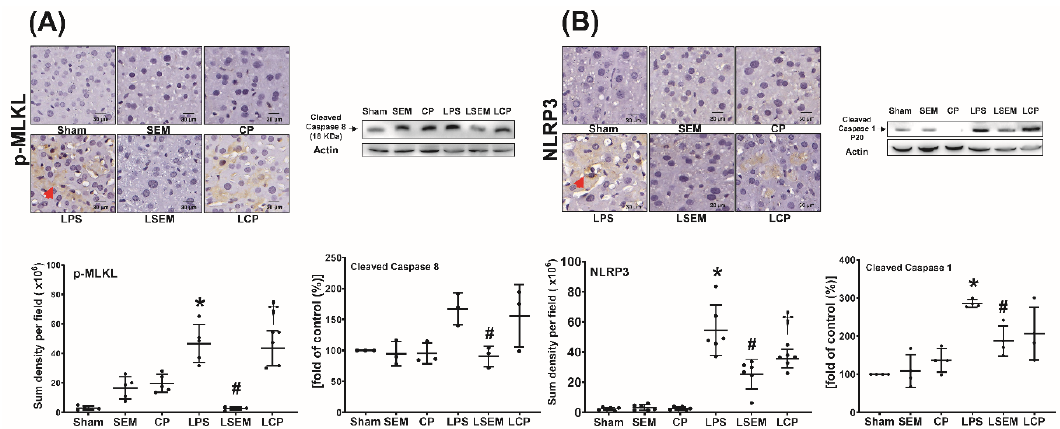
Figure 5. SEM18 peptide mitigates endotoxin-induced ( A ) necroptosis and ( B ) pyroptosis in the liver, measuredat24hafterlipopolysaccharide(LPS)ornormalsaline(NS)administration. ( A )Representative as measured at 24 h after lipopolysaccharide (LPS) or normal saline (NS) administration. ( A ) microscopic images of phosphorylated mixed lineage kinase domain-like pseudokinase (p-MLKL, red Representative microscopic images of phosphorylated mixed lineage kinase domain-like arrow) in liver tissues (200 × ) measured using immunohistochemistry assay and the quantitative sum pseudokinase (p-MLKL, red arrow) in liver tissues (200×) measured using immunohistochemistry assay and the quantitative sum intensity of p-MLKL. Representative gel photography of cleaved intensity of p-MLKL. Representative gel photography of cleaved caspase 8 and actin (the internal caspase 8 and actin (the internal standard) in liver tissues and the cleaved caspase 8/actin band standard) in liver tissues and the cleaved caspase 8 / actin band density. ( B ) Representative density. ( B ) Representative microscopic images of nod-like receptor protein 3 (NLRP3, red arrow) in microscopic images of nod-like receptor protein 3 (NLRP3, red arrow) in liver tissues assayed liver tissues assayed using immunohistochemistry staining assay (200×) and the quantitative sum intensity of NLRP3. Representative gel photography of cleaved caspase 1 and actin (the internal Representative gel photography of cleaved caspase 1 and actin (the internal standard) in liver standard) in liver tissues evaluated using immunoblotting assay and the cleaved caspase 1/actin band density. Sham: the NS group; SEM: the NS plus SEM18 peptide group; CP: the NS plus control peptide